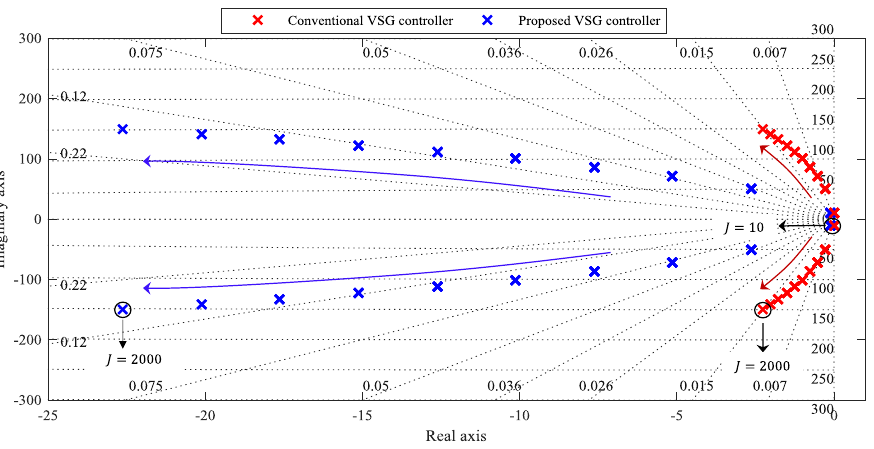
Figure 9. Root locus plot of the converters with conventional and proposed VSG control.